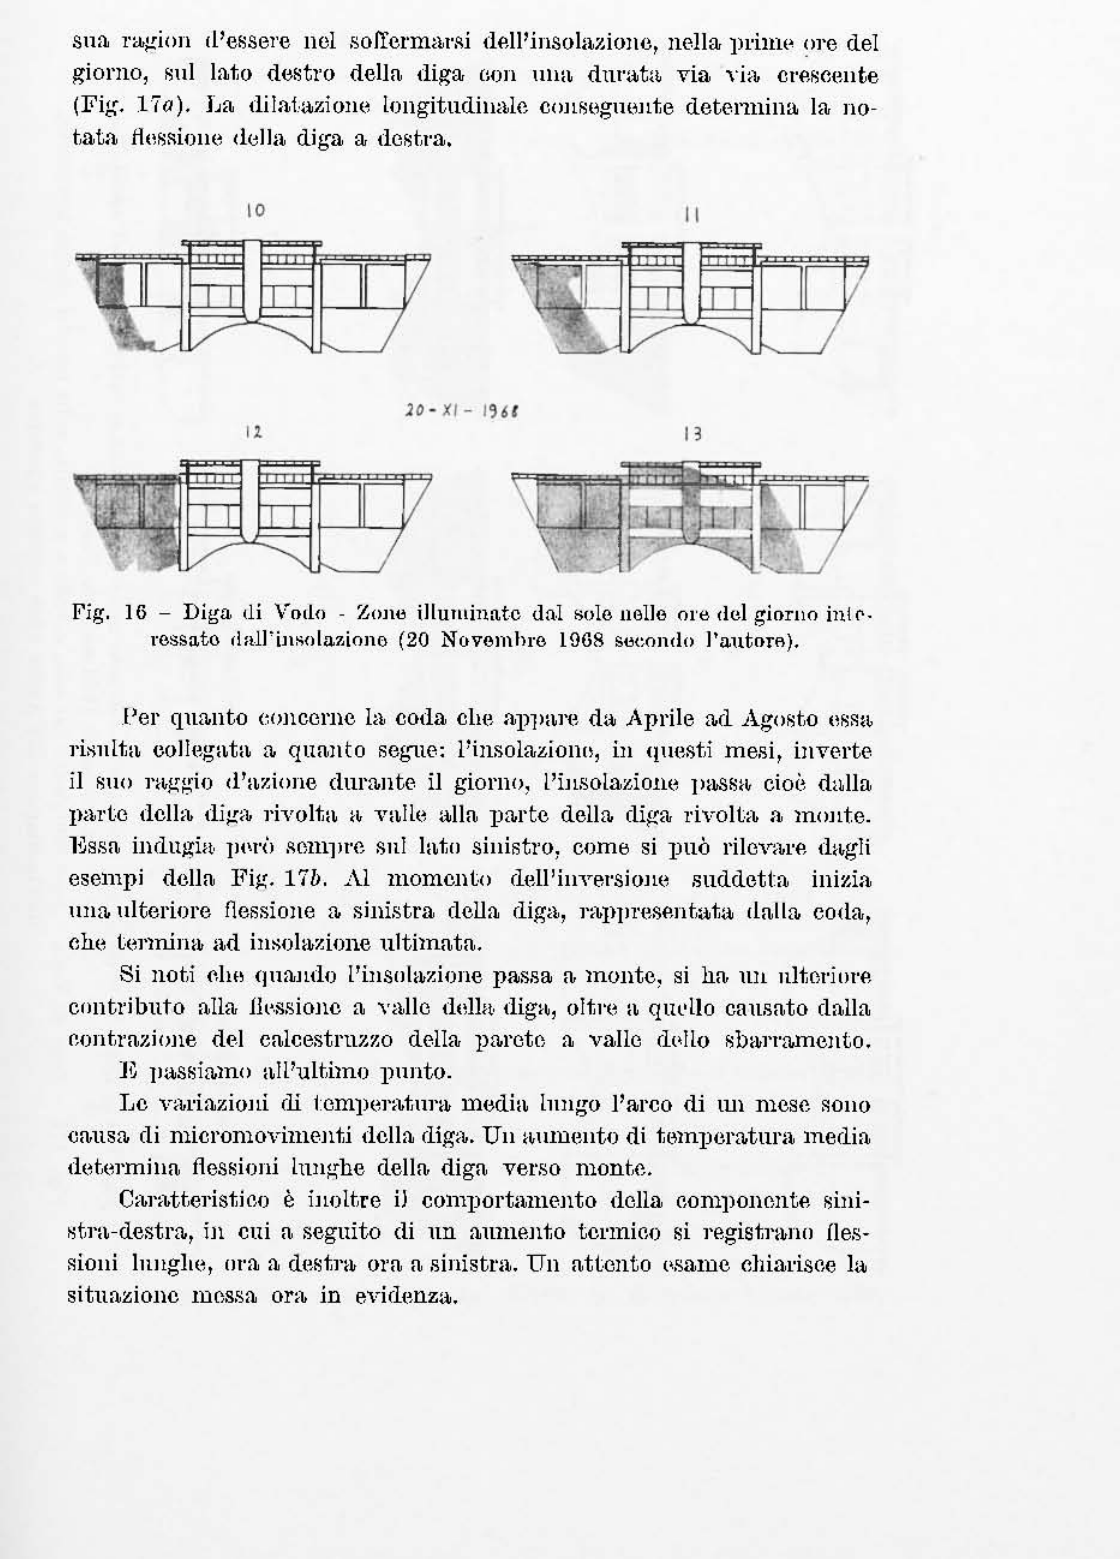
una ulteriore flessione a sinistra della (lig11, rl.PIll'esentata (Ialla coda, che t.ermina ad insolazione